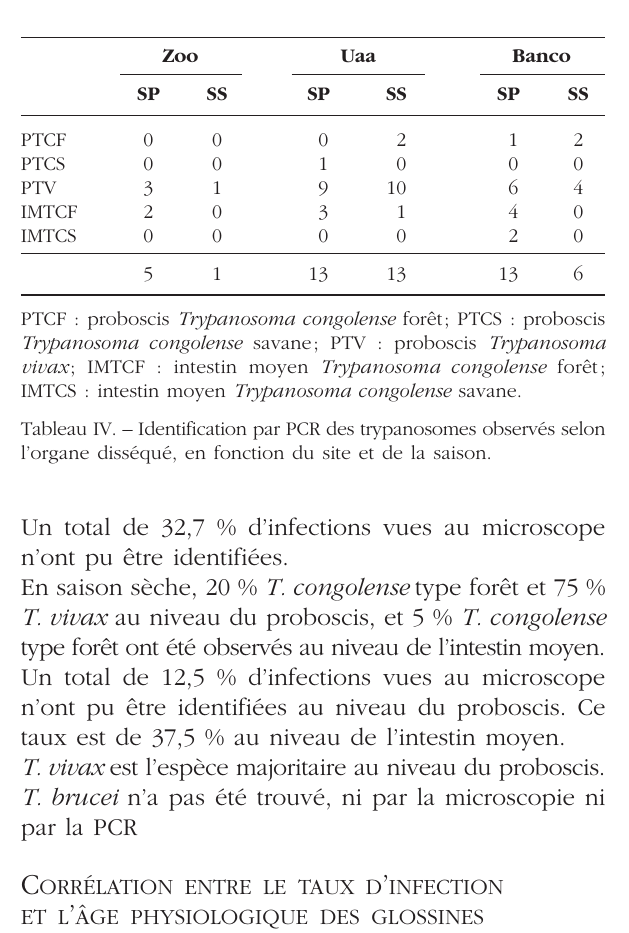
Tableau III. – Nombre d’infections par des trypanosomes selon l’organe disséqué en fonction du site et de la saison.